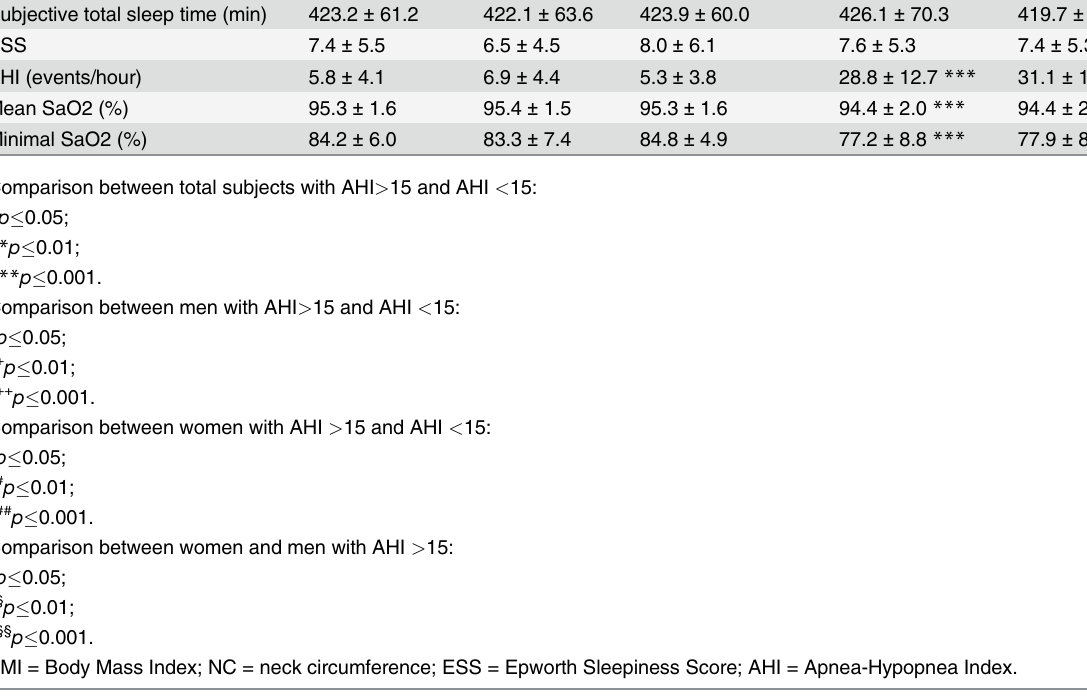
Among 78 subjects with AHI < 5/hr in home sleep studies, 22 sleepy subjects (i.e. ESS > 10) were invited to undergo full PSG in our hospital for confirmation of OSAS. Only 13 (59%) sub- jects agreed to undergo PSG. Six subjects were confirmed to have OSAS in subsequent full PSG with AHI (cid:1) 5/hr. Together with those diagnosed to have OSAS by home sleep studies, 141 sub- jects who had AHI (cid:1) 15/hr or AHI (cid:1) 5/hr plus cardiovascular risk factors or AHI (cid:1) 5/hr plus ESS score (cid:1) 10 were offered CPAP titration with the AutoSet device after receiving a basic CPAP education package[25, 26]. The mean (SD) of CPAP pressure titrated was 12.0 (1.4) cmH2O. Only 30 elderly subjects accepted home CPAP treatment whereas 59% of them ad- hered to treatment at 4.6 (2.1) hrs/night at 3 months, 56% at 4.6 (2.2) hrs/night at 6 months,